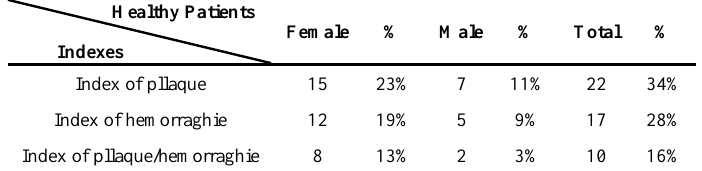
Table 6. Data on healthy patients - gender, based on periodontal indices, for the second group of patients